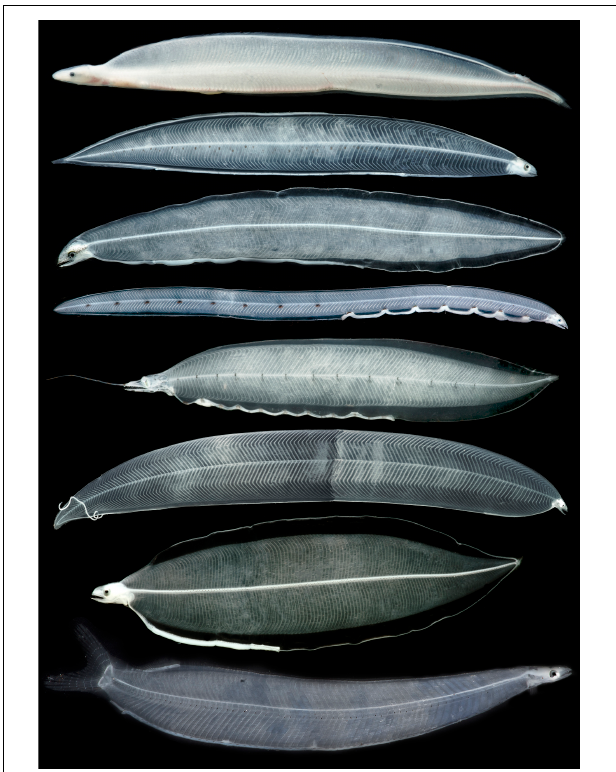
FIGURE 1 | A sample of morphological diversity in leptocephalus larvae and a transforming juvenile. Top to bottom: transforming Congridae? juvenile eel, congrid Rhynchoconger flavus , unidentified muraenid similar to Gymnothorax miliaris , ophichthid Myrichthys breviceps , synaphobranchid Ilyophinae sp. D 3 from Straits of Florida, congrid Ariosoma anale , chlopsid Chlopsis bicolor , and elopid Elops smithii . Images are not to scale and are provided to show a sample of the diversity of leptocephalus morphology and pigmentation. All photos by Dante